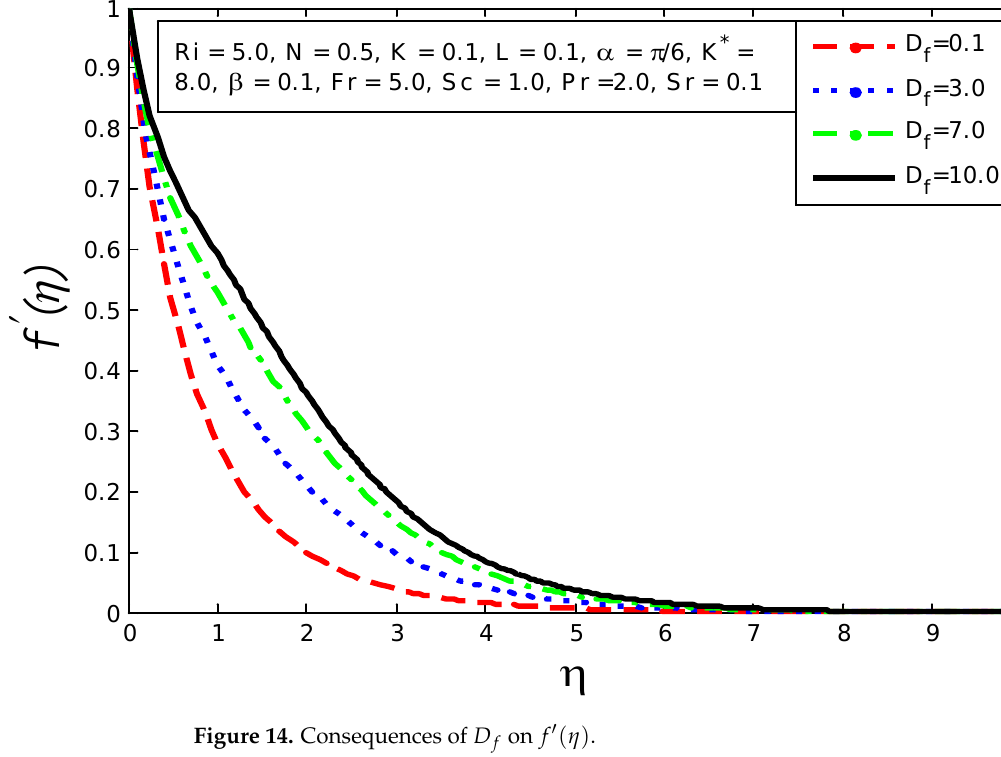
Figure 14. Consequences of D f on f (cid:48) ( η ) .